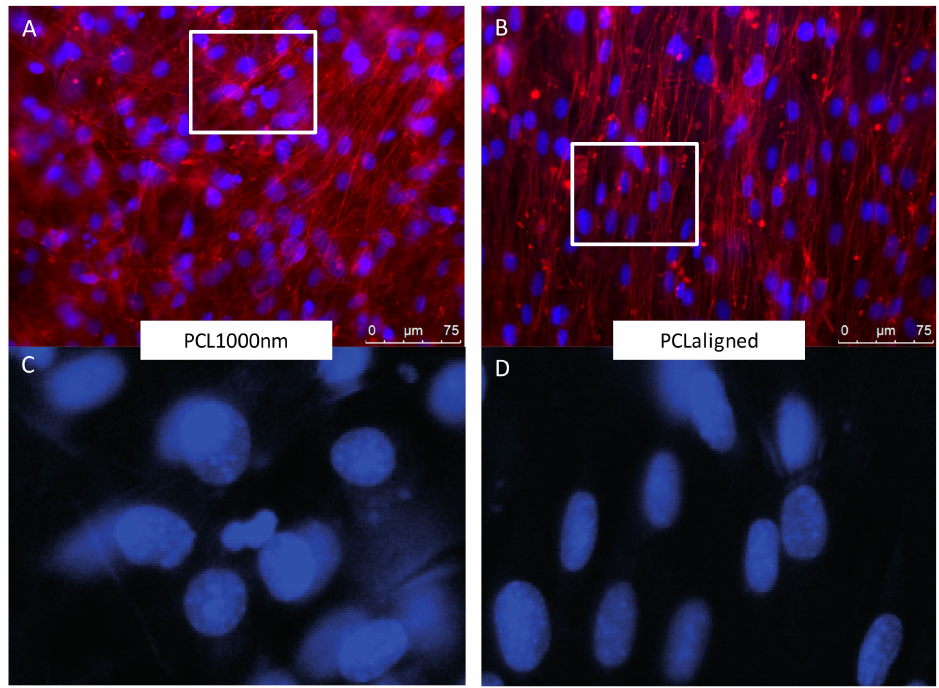
Figure 5. Fluorescence microscopy observations of C3H10T1/2 cells cultured for 96 h on PCL1000nm ( A , B ) and PCLaligned ( C , D ) scaffolds. ( A , C ) Actin filaments visualized with rhodamine-phalloidine ( red ) and nuclei visualized with DAPI ( blue ). ( B , D ) higher magnifications of nuclei (DAPI) of region of interest (white rectangles in A , C